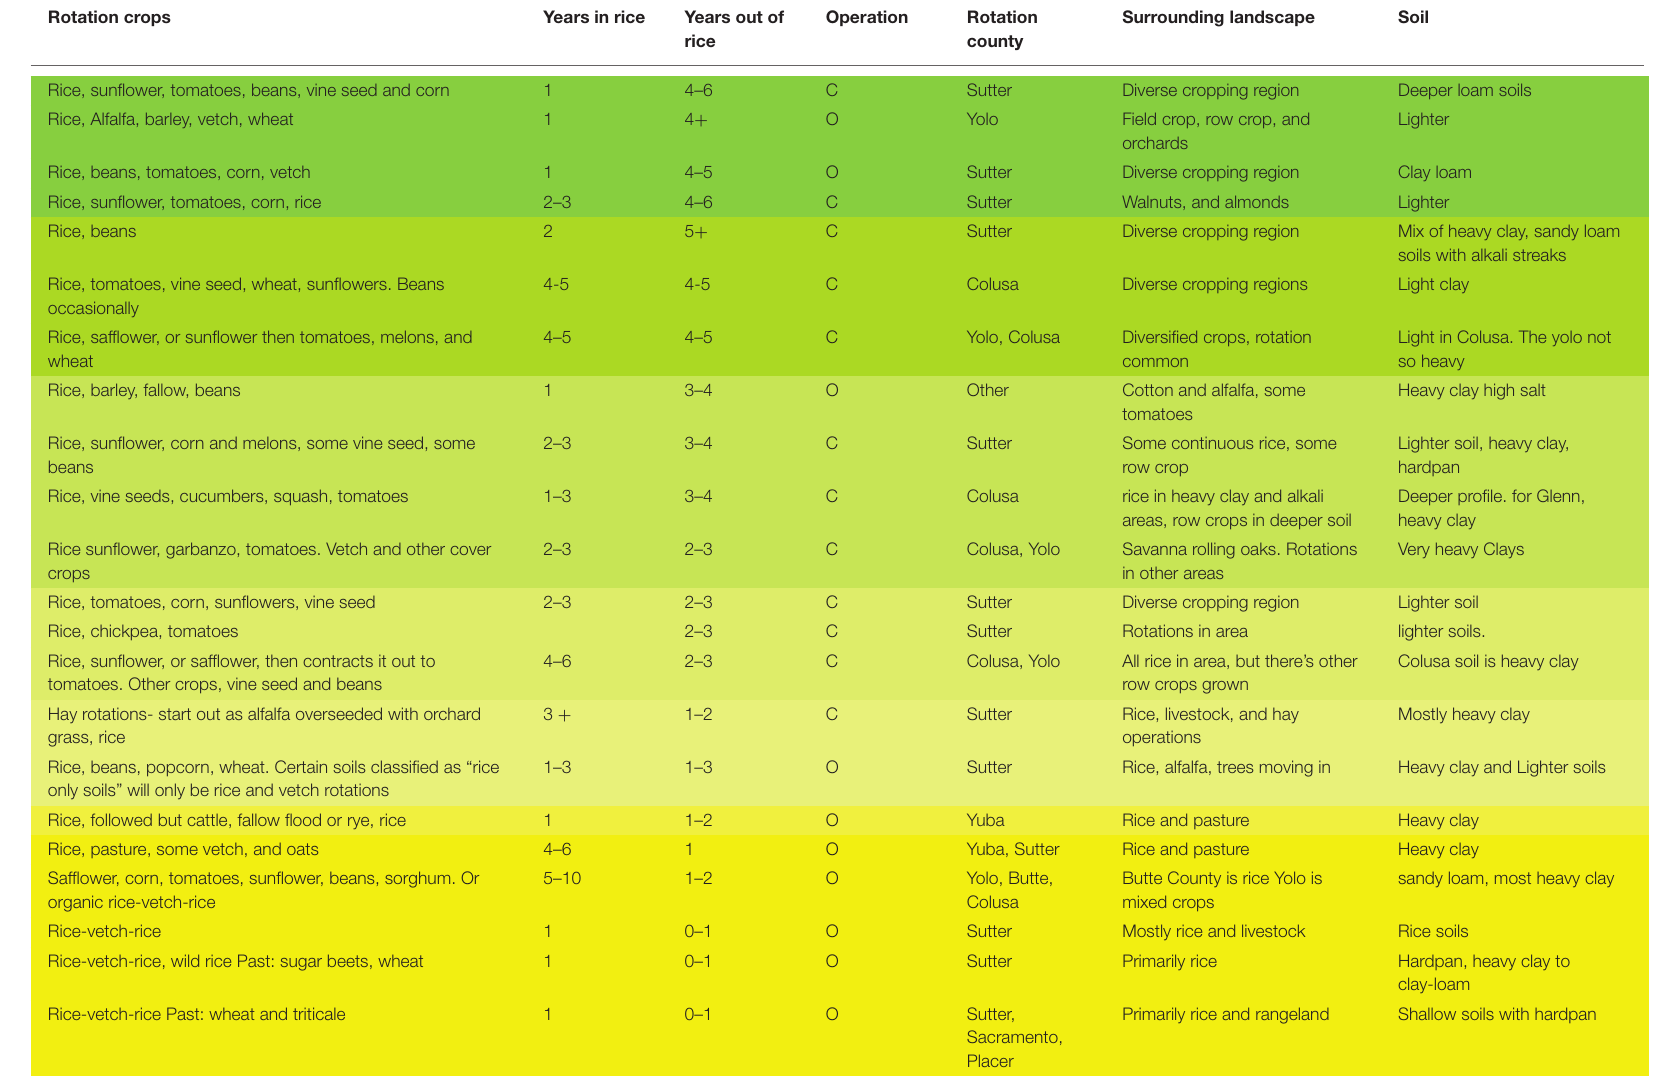
Rotations are ranked with the most diverse rotations at the top (green color - more crops in rotations/more years producing other crops) to the least diverse rotations at the bottom (yellow color - less crops in rotation/more years producing